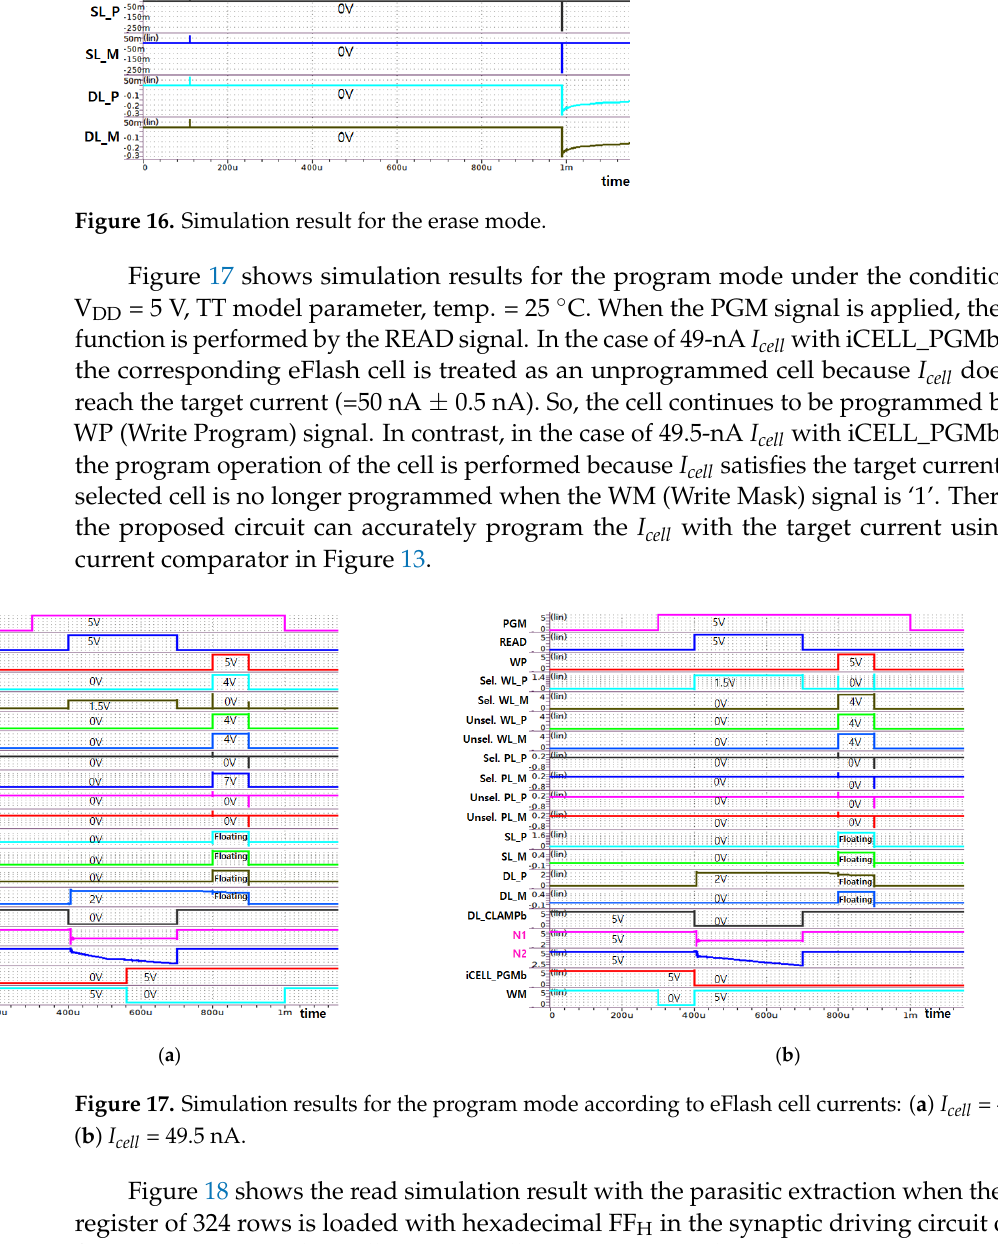
Figure 18. Post-layout simulation result of read operation when the shift register of 324 rows is loaded with hexadecimal FF.